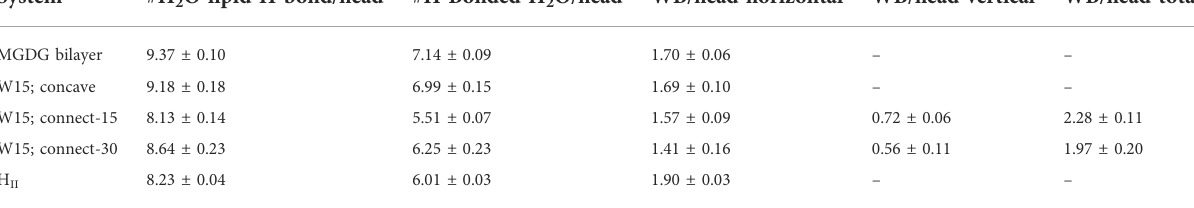
TABLE 3 Number of lipid-water interactions in the MGDG lamellar and non-lamellar systems. System